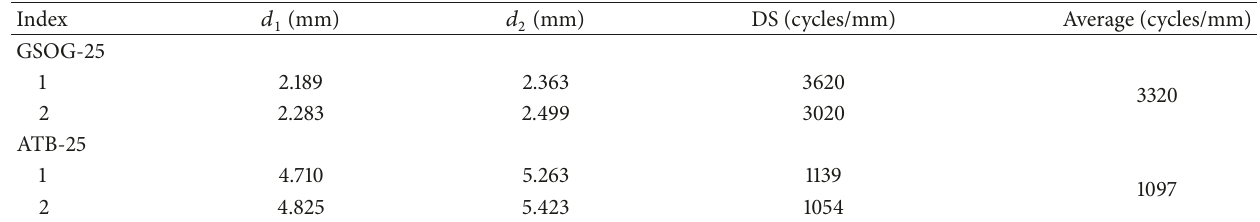
Table 15: Rutting test results.